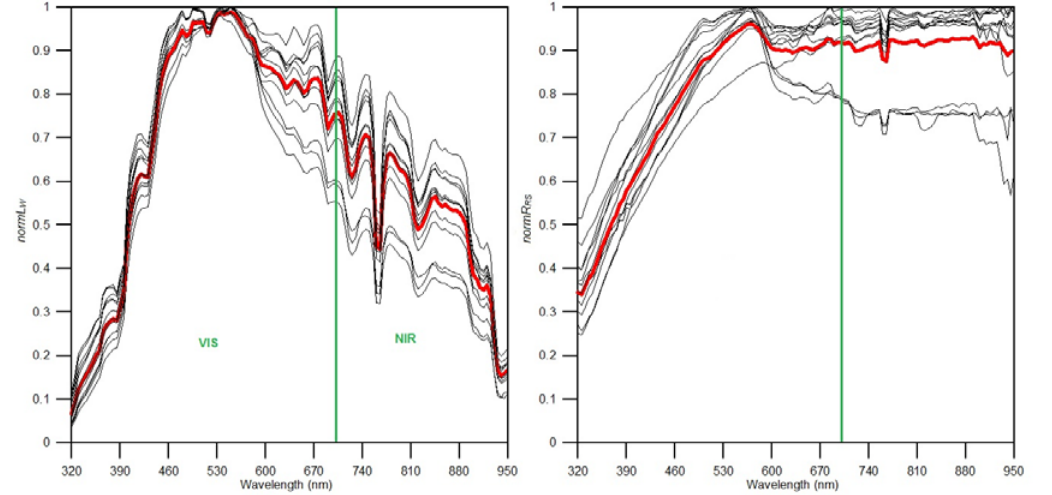
Figure 7. Thirteen samples of spectral shapes for sea surface images strongly affected by sunglint from the sunglint image set Ns . On the left is the normalized water leaving radiance, normL and on the right is the normalized remote sensing reflectance, normR W It is observed that sunglint enhances the measured signal especially in the NIR for both water leaving and remote sensing reflectance. The red spectrum shows the mean spectral shape and the green line highlights the VIS and NIR spectral ranges.